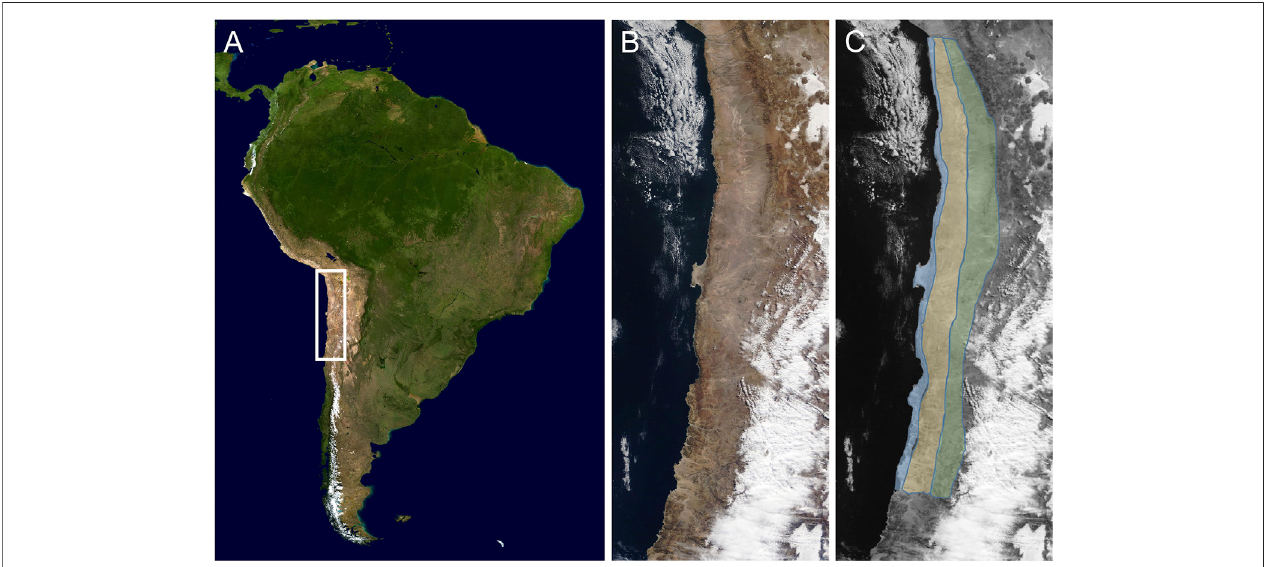
FIGURE1| Location ofthe Atacama Desert. (A) Location oftheAtacama inSouth America. (B) Zoom ofthewhiteframeshown inA. Note themassesofcloudsat theeasternsideoftheAndesoverArgentinaandBolivia. (C) GenerallocationoftheCoastalRange(lightblue),thehyperaridcore(Yellow),andtheAndesMountainsand its foothills (green).